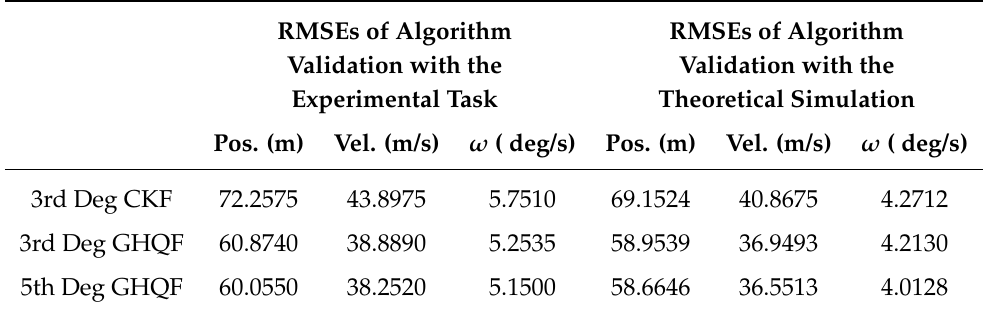
Table 2. Average RMSE for a position (Pos.), velocity (Vel.), and rotation rate ( ω ) implemented by experimental and theoretical